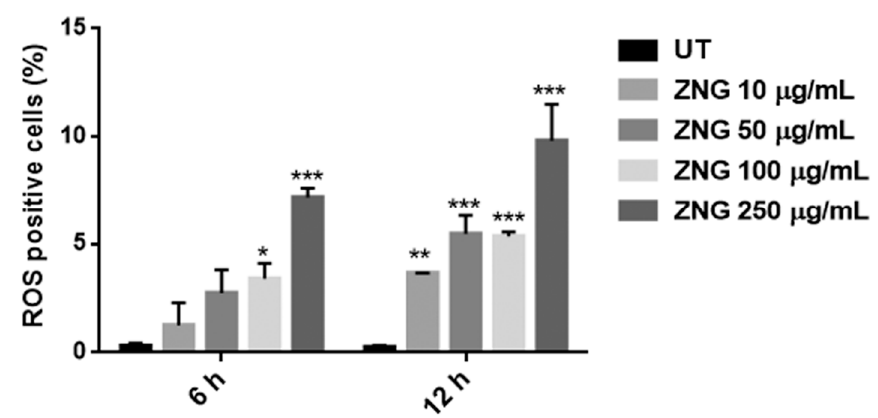
Figure 3. Detection of ROS content using H 2 DCFDA staining. C. albicans cells untreated (UT) or treated with the various concentrations of ZNGs, for 6 h and 12 h, were stained to detect the intracellular ROS formation. The bars represent the percentage of fluorescence-positive cells with respect to total cells. Means and SDs are shown (* p < 0.05, ** p < 0.01, and *** p < 0.001 when compared with the untreated cells).